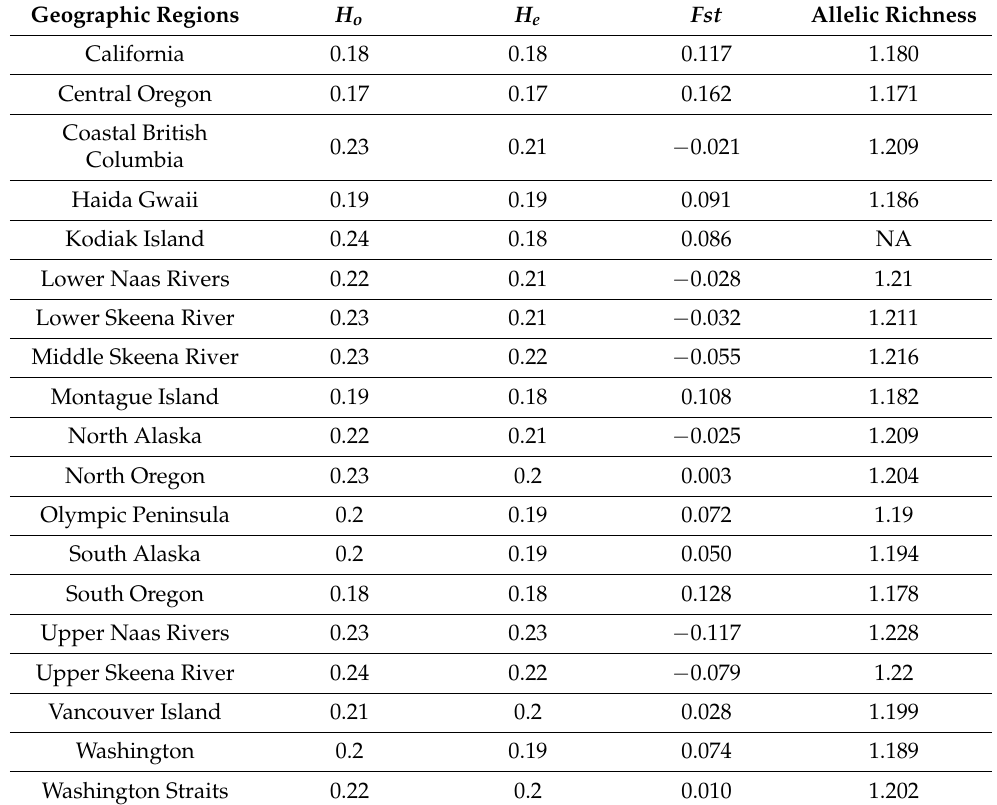
Table 2. Differentiation and diversity statistics of the geographic regions within the IUFRO